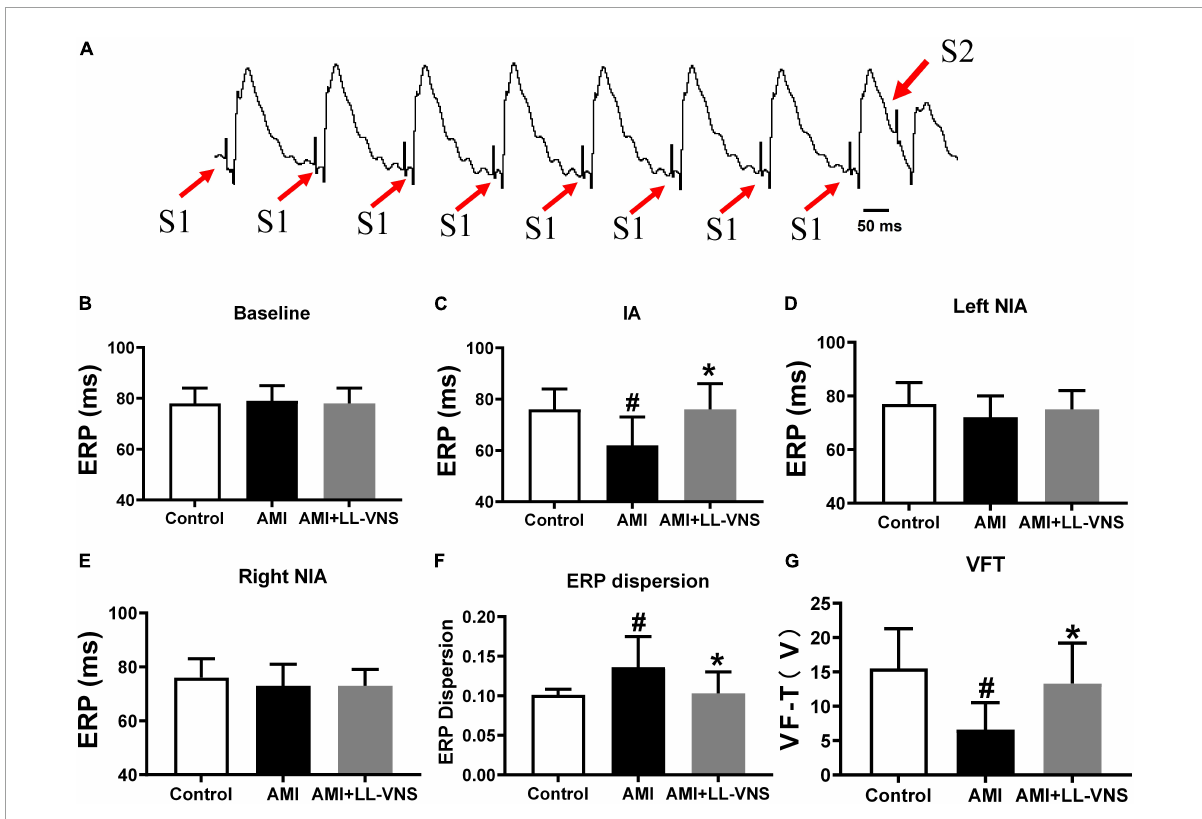
FIGURE2 Effects of LL-VNS on the electrophysiological properties of the ventricles. (A) Typical example of S1–S2 stimulation scheme in the measurement of ventricular ERP. (B) No significant differences among the three groups were observed at baseline. (C) LL-VNS prolonged ischemia-induced ERP measured at the ischemic area (IA). (D,E) No significant differences were observed among the three groups in ERP measured at the left or right non-ischemic area. (F) LL-VNS significantly reduced ischemia-induced ERP dispersion. (G) LL-VNS significantly mitigated ischemia-induced reduction in VFT. AMI, acute myocardial infarction; ERP, effective refractory period; IA, ischemic area; LL-VNS, low-level vagus nerve stimulation; NIA, non-ischemic area; VFT, ventricular fibrillation threshold. n = 15 per group. # P < 0.01 in a comparison with the Control group; * P < 0.01 in a comparison with the AMI